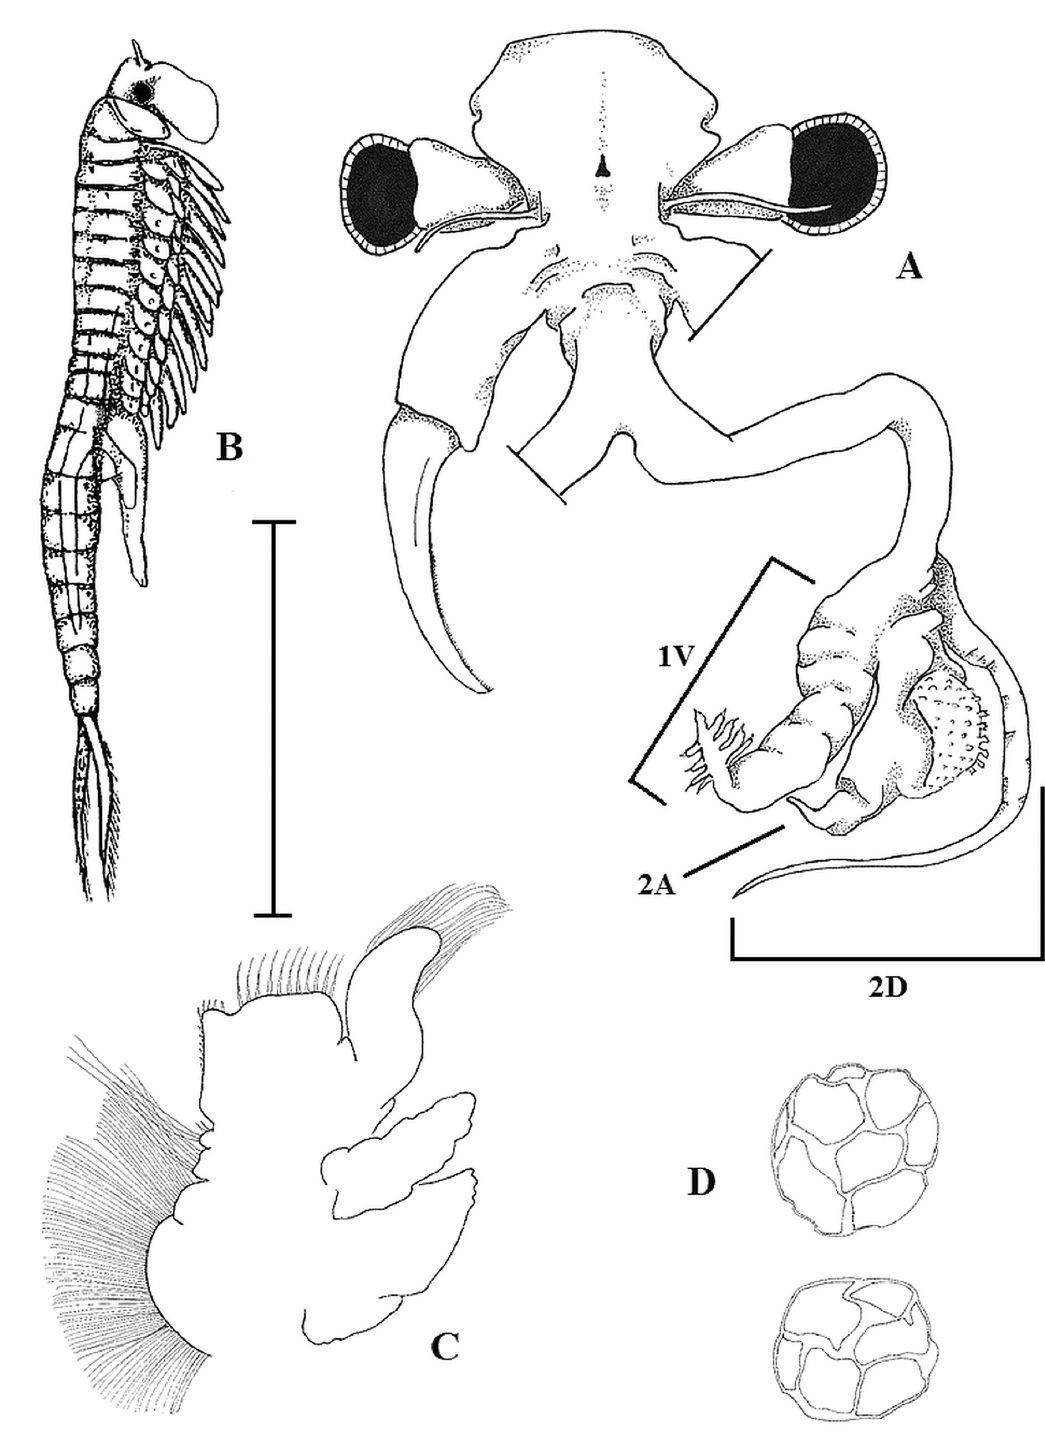
Fig. 2. Dendrocephalus proeliator sp. nov. Paratypes; Florida, Dade County; FLMNH Type 9041. A. Male head, anterior view. B. Female, right lateral view. C. Right limb V, anterior view. D. Two examples of the egg. Abbreviations: 1V = first ventral branch; 2A = apical branch; 2D = dorsal branch (terminology follows Pereira 1983). Scale bar: A = 2 mm; B = 7 mm; C = 1 mm; D = 1.5